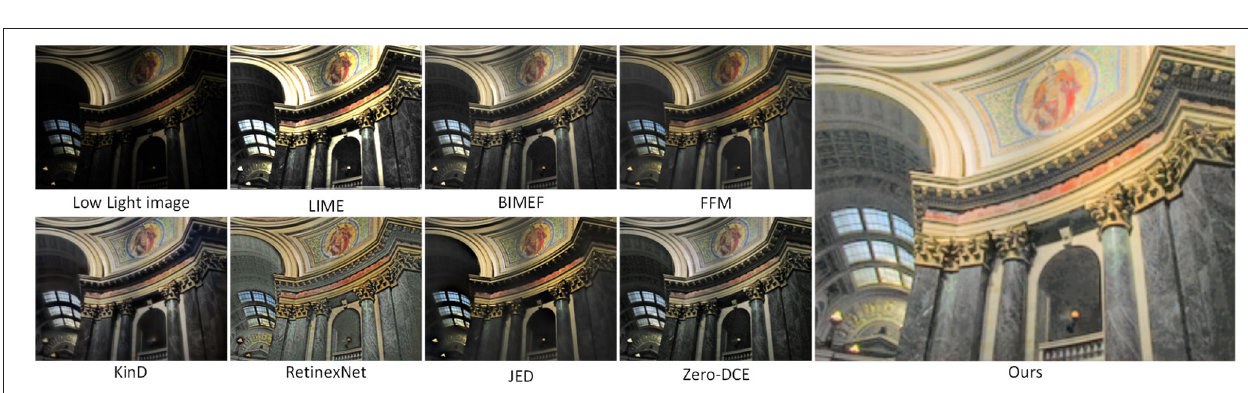
FIGURE 10 | Comparison of various low light image enhancement methods using indoor images from the MEF